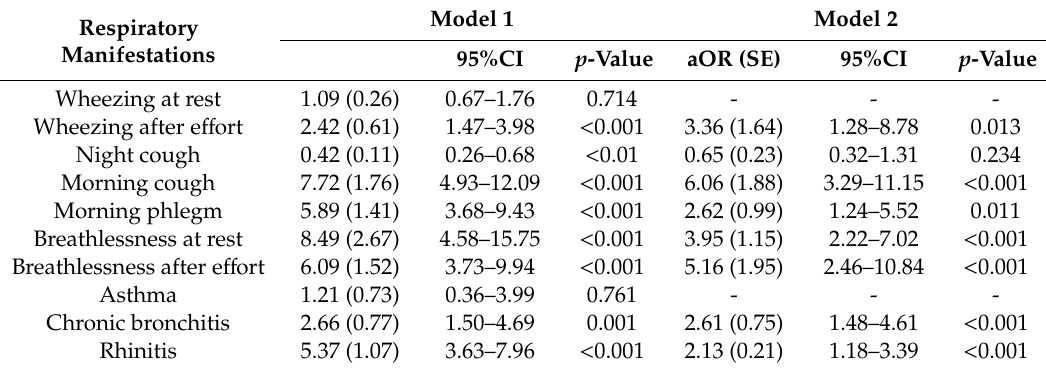
Table 3. Association between respiratory manifestations and stone quarry work.